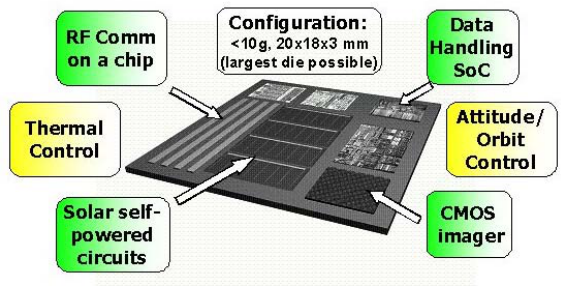
Figure 7. SpaceShip: a monolithic satellite-on-a-chip [28].